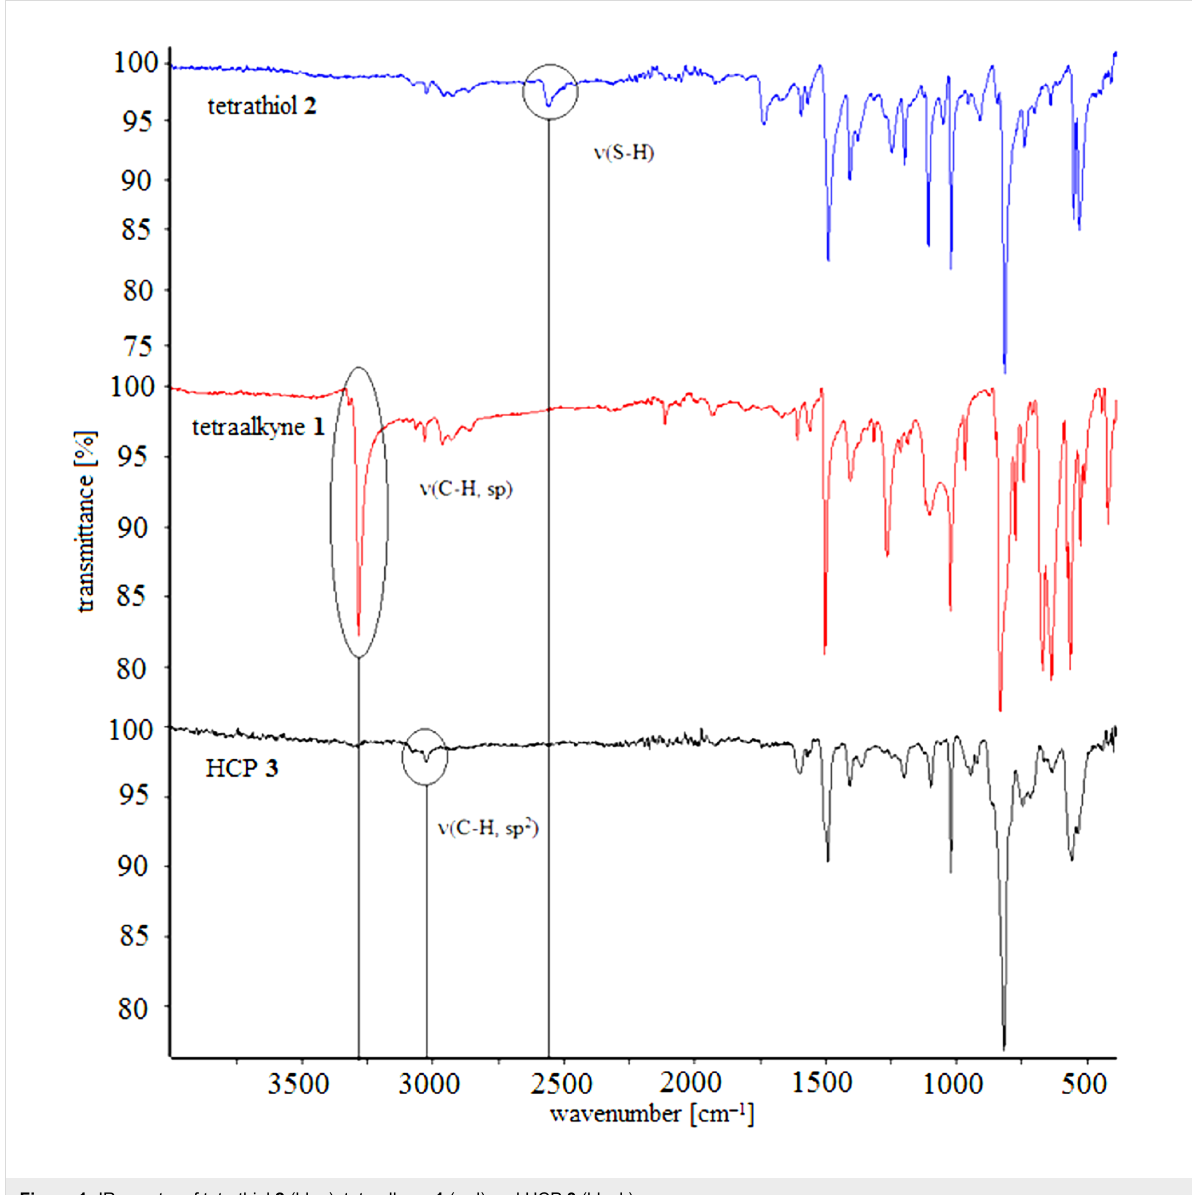
Figure 1: IR-spectra of tetrathiol 2 (blue), tetraalkyne 1 (red) and HCP 3